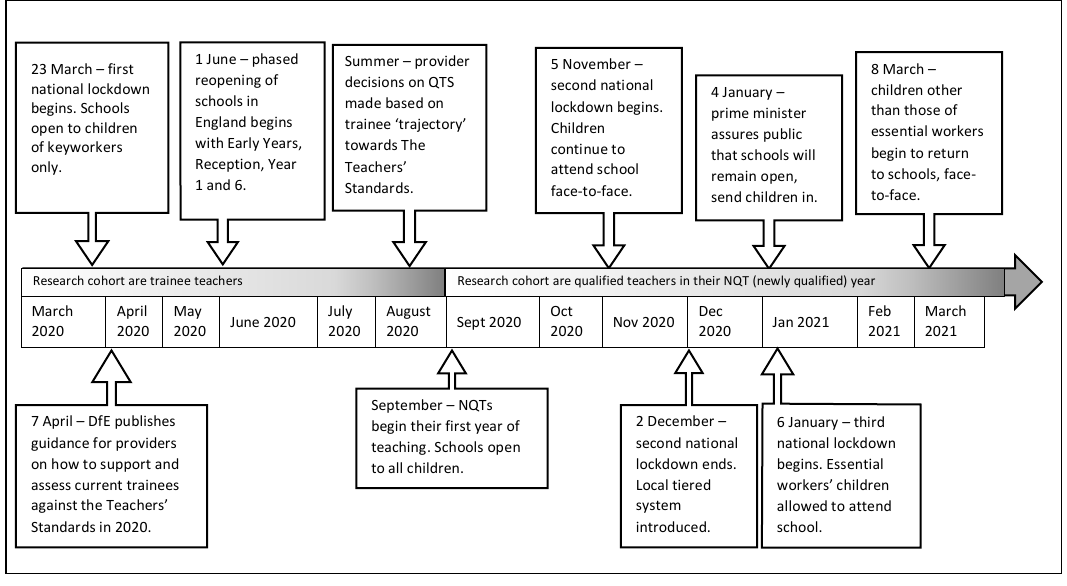
Figure 1. Timeline of 2020/1 Covid-19 events linked to initial teacher education in England